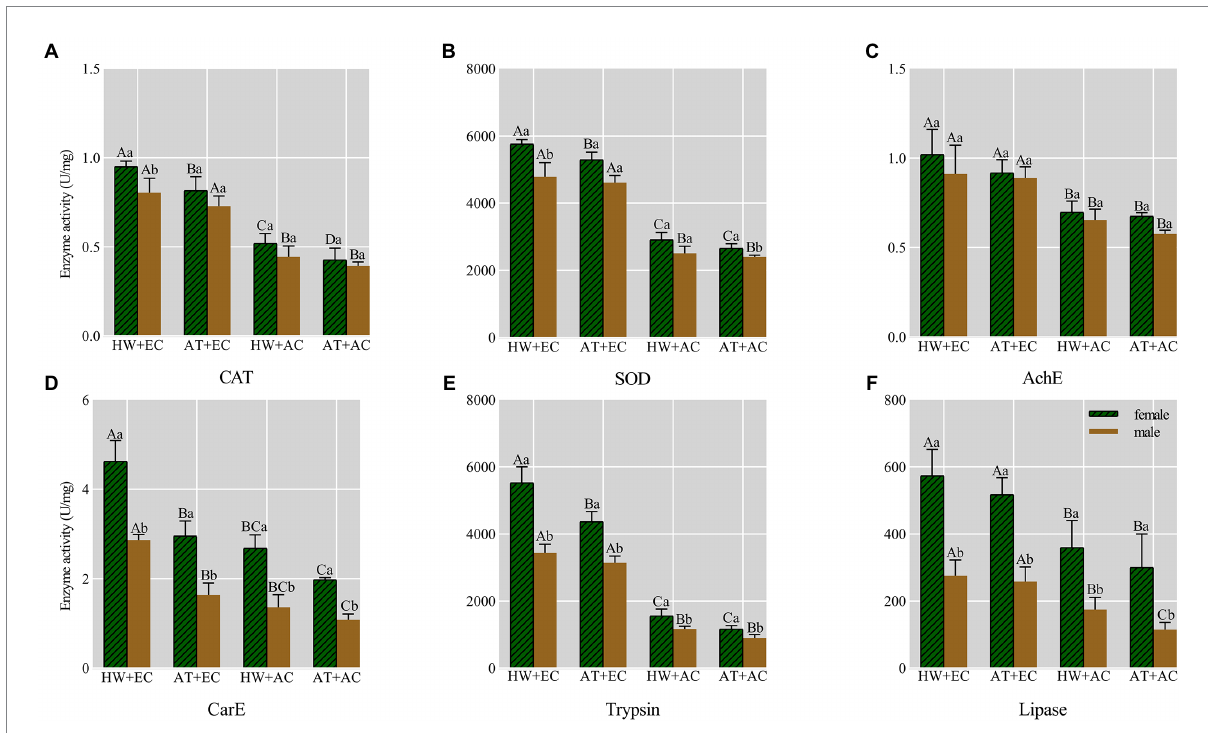
FIGURE 4 Effect on six enzyme activities of Ophraella communa after feeding on common ragweed grown under different treatment conditions. The green column denotes the female enzyme activity, the brown column denotes the male enzyme activity; AT denotes the ambient temperature condition; HW denotes the heat wave condition. EC and AC represent elevated atmosphere CO 2 concentration and ambient atmosphere CO 2 concentration, respectively; Different uppercase letters on the column indicate statistical differences between different genders, different lowercase letters on the column represent statistical differences between different treatment at P < 0.05, as determined by an ANOVA: LSD